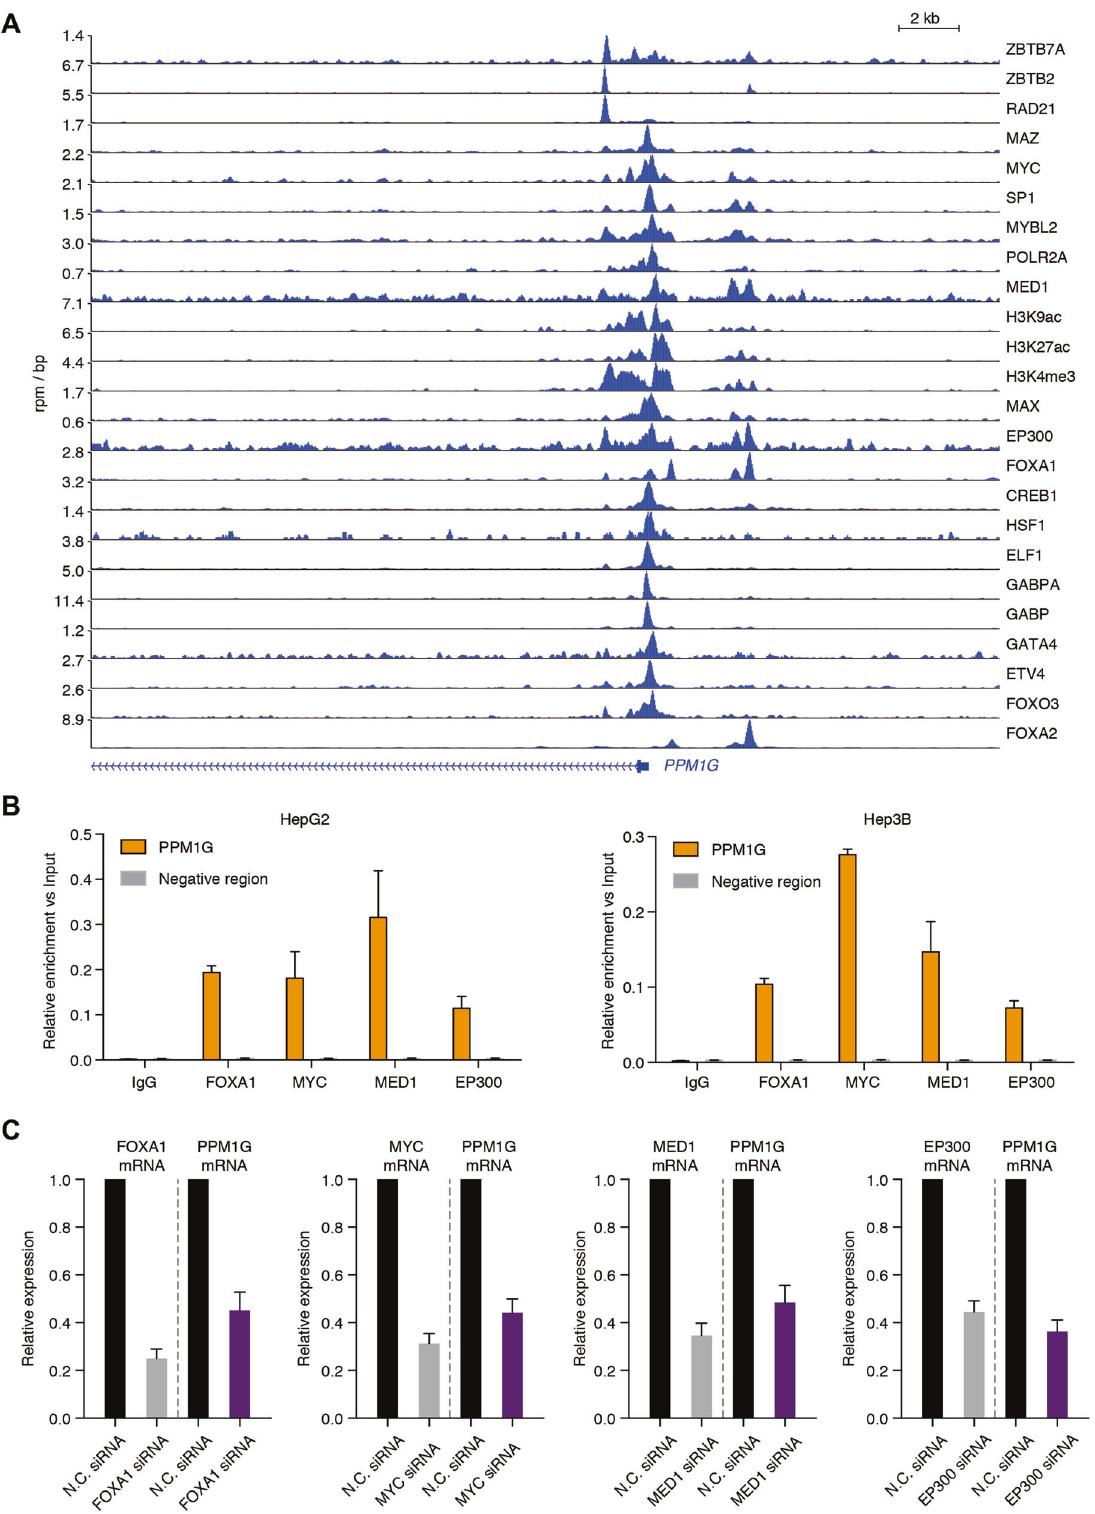
Fig. 7 PPM1G was transactivated by multiple transcription factors and co-activators. A ChIP-seq analysis of transcription factors and co- activators binding on the regulatory region of PPM1G was completed. The ChIP-seq in HCC cell lines was retrieved from the GEO database. B ChIP-qPCR analysis of FOXA1, MYC, MED1, and EP300 binding on the promoter region of PPM1G in HepG2 and Hep3B cells was completed. C Knockdown of FOXA1, MYC, MED1, and EP300 decreased the expression of PPM1G. siRNA targeting FOXA1, MYC, MED1, EP300, or non- targeting siRNAs were transduced into the Hep3B cells. The knockdown ef fi ciency and the expression of PPM1G were detected by RT-qPCR experiments.